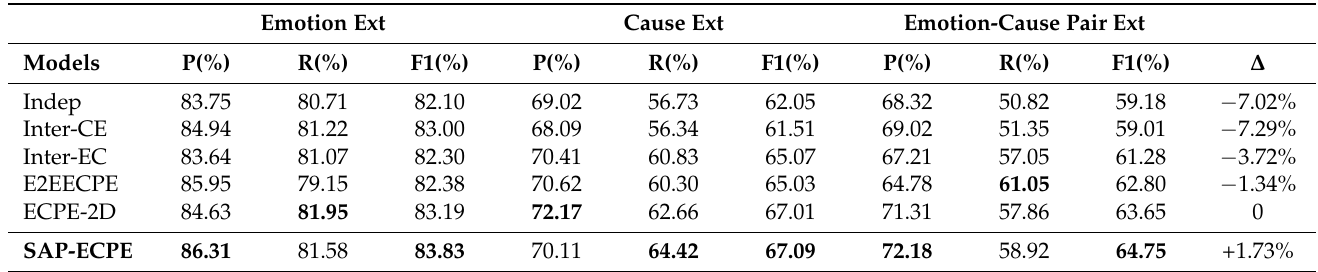
Table 2. Comparison of model results for ECPE task, emotion extraction and cause extraction. The maximum value is marked in bold.